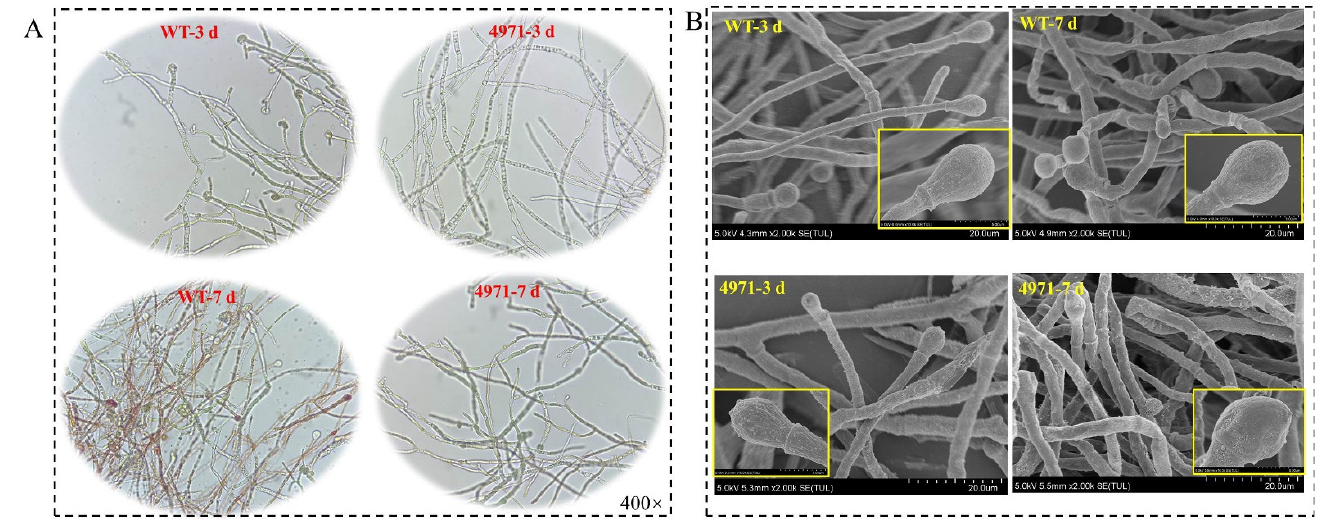
Figure 6. Image analysis of the mycelial morphologies of M. purpureus LQ-6 (WT) and M. purpureus Δ 4971 during submerged batch-fermentation by using biological microscope ( A ) and scanning electron microscopy ( B ).